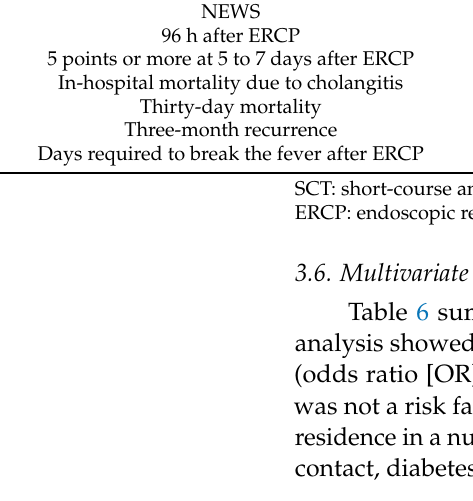
Table 6. Multivariate analysis for increased severity after admission.